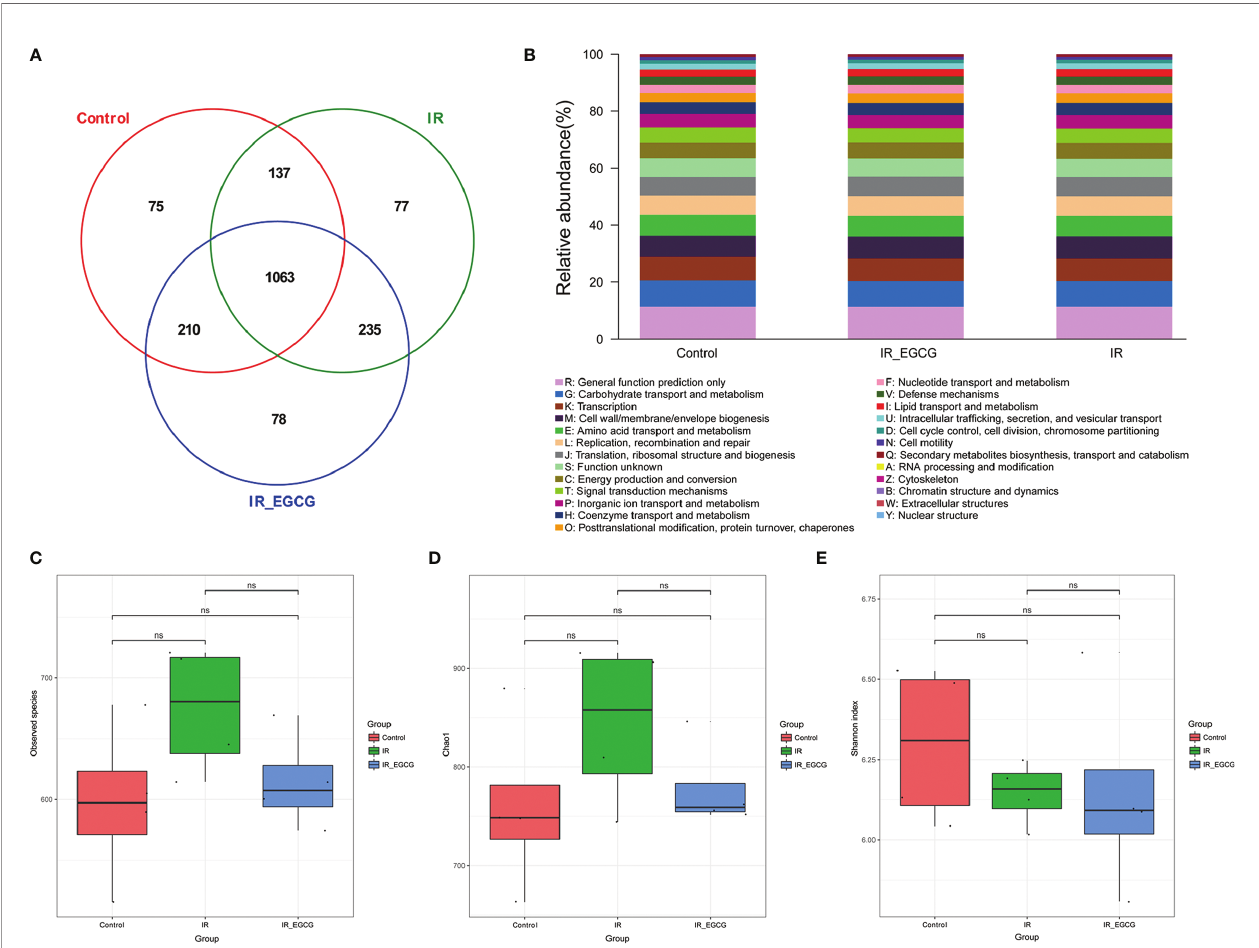
FIGURE 3 | Effects of EGCG treatment on gut bacterial composition. (A) Venn diagram showing the common and unique OTUs across all groups. The numbers in the Venn diagram indicate the number of OTUs. (B) Relative abundance of functional categories in gut microbiota among the three groups as predicted by Functional Annotation of Prokaryotic Taxa (FAPROTAX). The observed species number (C) , Chao1 index (D) and the Shannon diversity index (E) of the intestinal bacterial fl ora. Results are presented as mean ± SD. ns, not signi fi cant; n = 4.